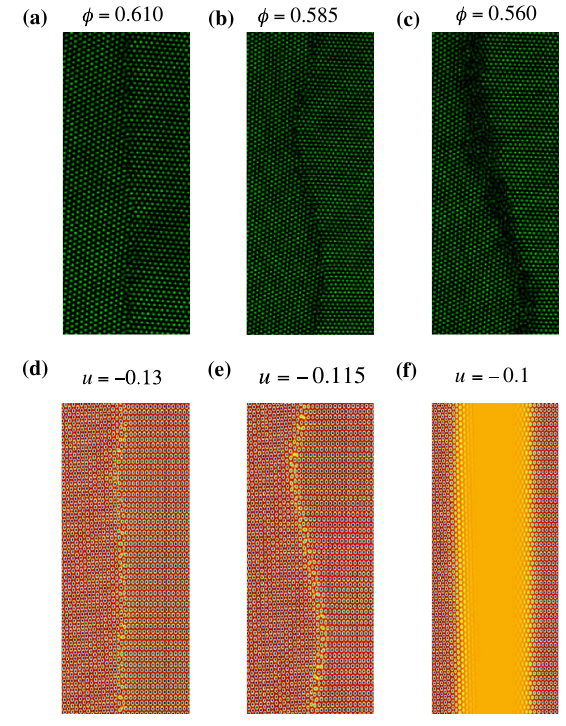
FIG. 11. (a) – (c) The grain boundary with θ ¼ 28 ° in the experiment. These are subareas of Figs. 1(d), 1(f), and 1(h). (d) – (f) The grain boundary with θ ¼ 25 . 8 ° at different effective temperatures u in the phase field simulation.